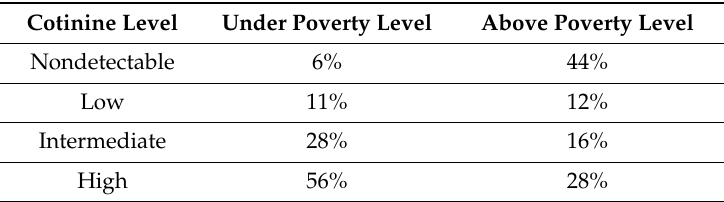
Table 1. Cotinine level based on poverty status ( n = 43).